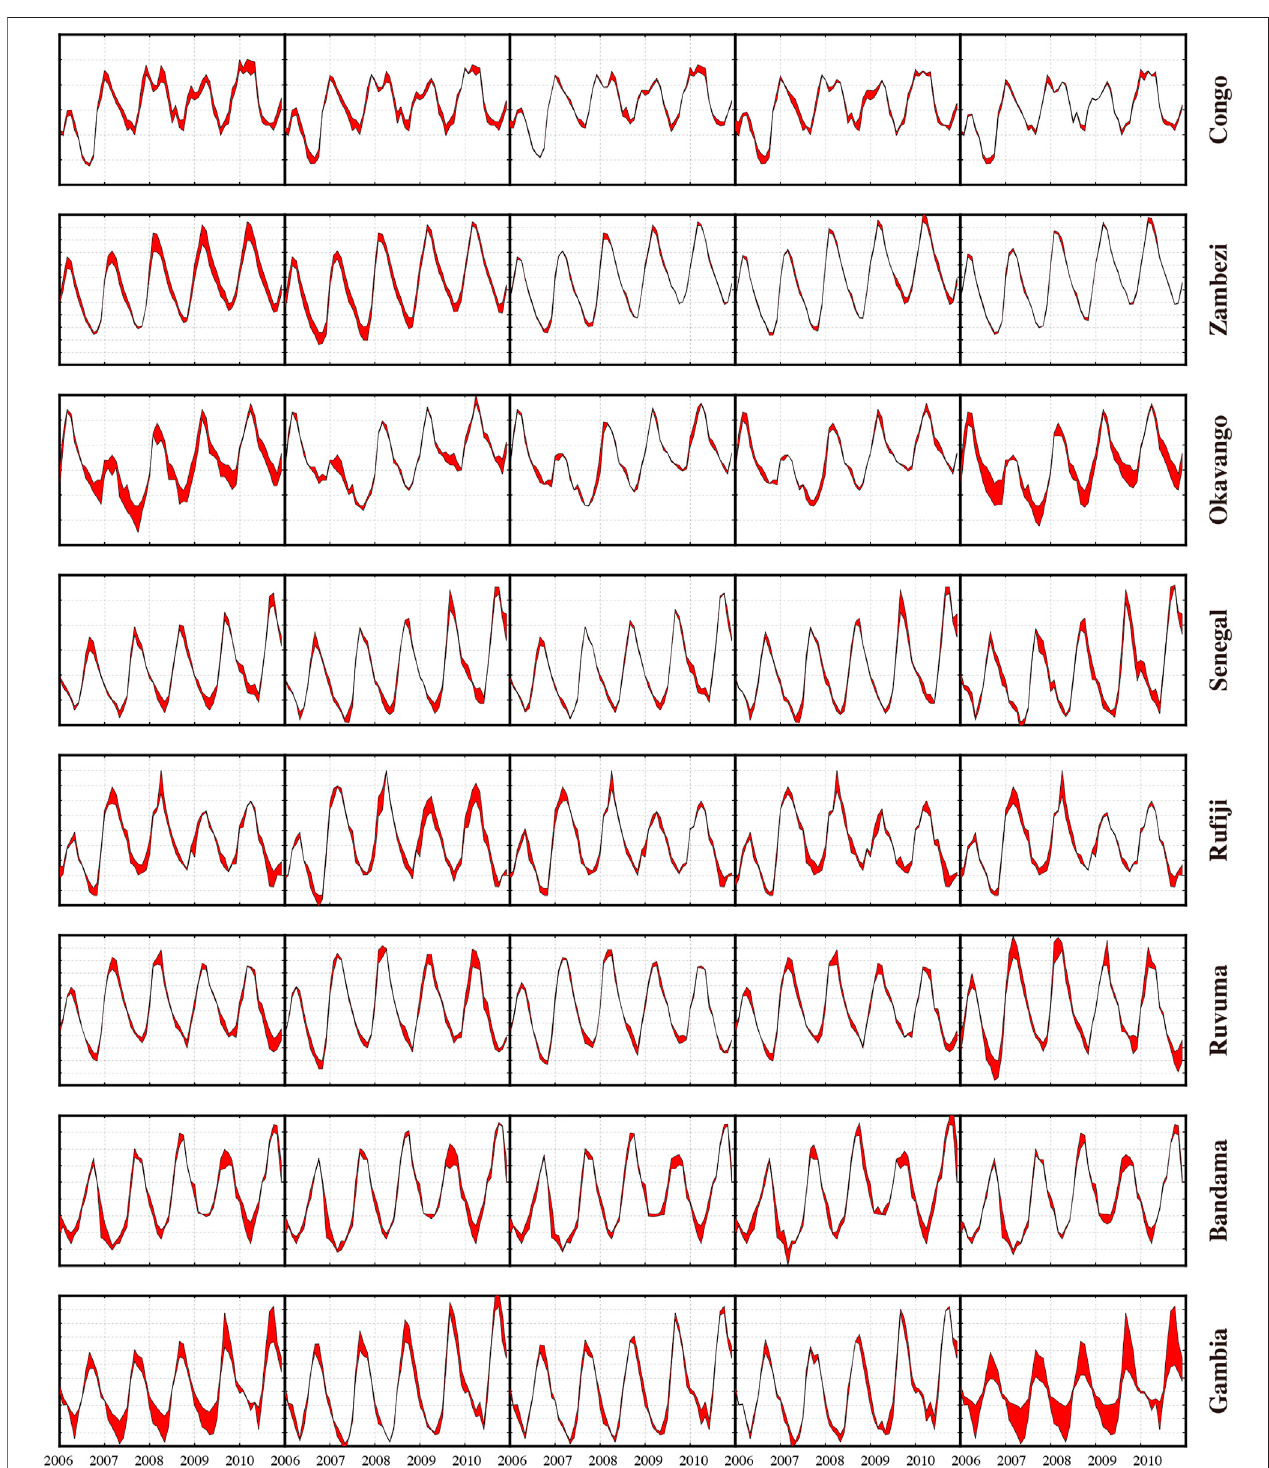
FIGURE 11 | Fill plots to illustrate the gap between the time series derived from improved forward modeling method ant that from different approaches over eight Africa river basins: (1) CSR Tellus Mass Grid without scale factor, (2) CSR Tellus Mass Grid with scale factor, (3) CSR mascon solution, (4) JPL mascon solution, (5) general forward modeling method. The ordinate of each subplot is different. The amount of red is the differences between the result from improved forward modeling method and that from corresponding approach. Thus less red means better agreement with improved forward modeling method.